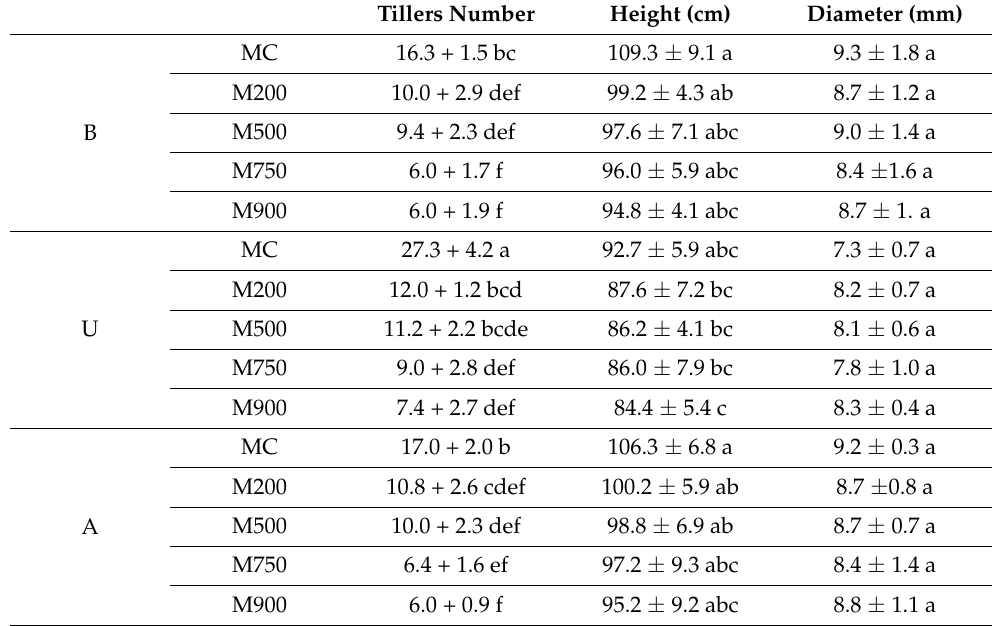
Table 3. Tiller numbers per pot, height, and stem diameter of the cultivars (B, U, and A) in soils with a gradient TE concentration (MC, M200, M500, M750, and M900) at the end of the second growing period. Values are presented as means ± SD. Different letters refer to significant differences between plants (Turkey HSD test, n = 5, p ≤ 0.05). Tillers Number Height (cm) Diameter